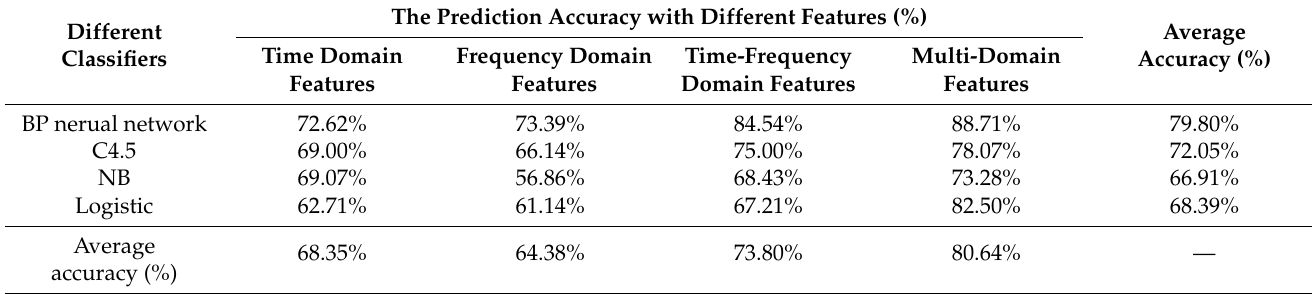
Table 6. Classification accuracy of different classifiers with different domain features.